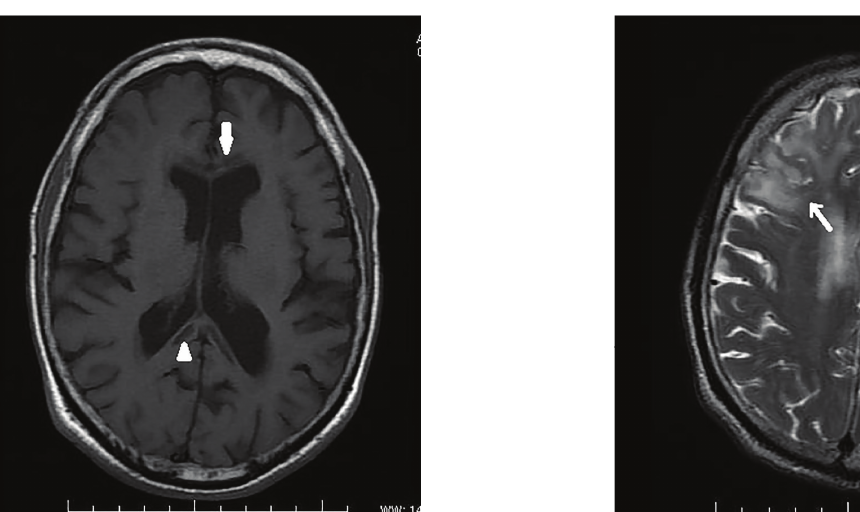
Figure 1: Axial T1 weighted image showing hypointensity of the genu (white arrow) and splenium (white arrowhead) of corpus callosum.